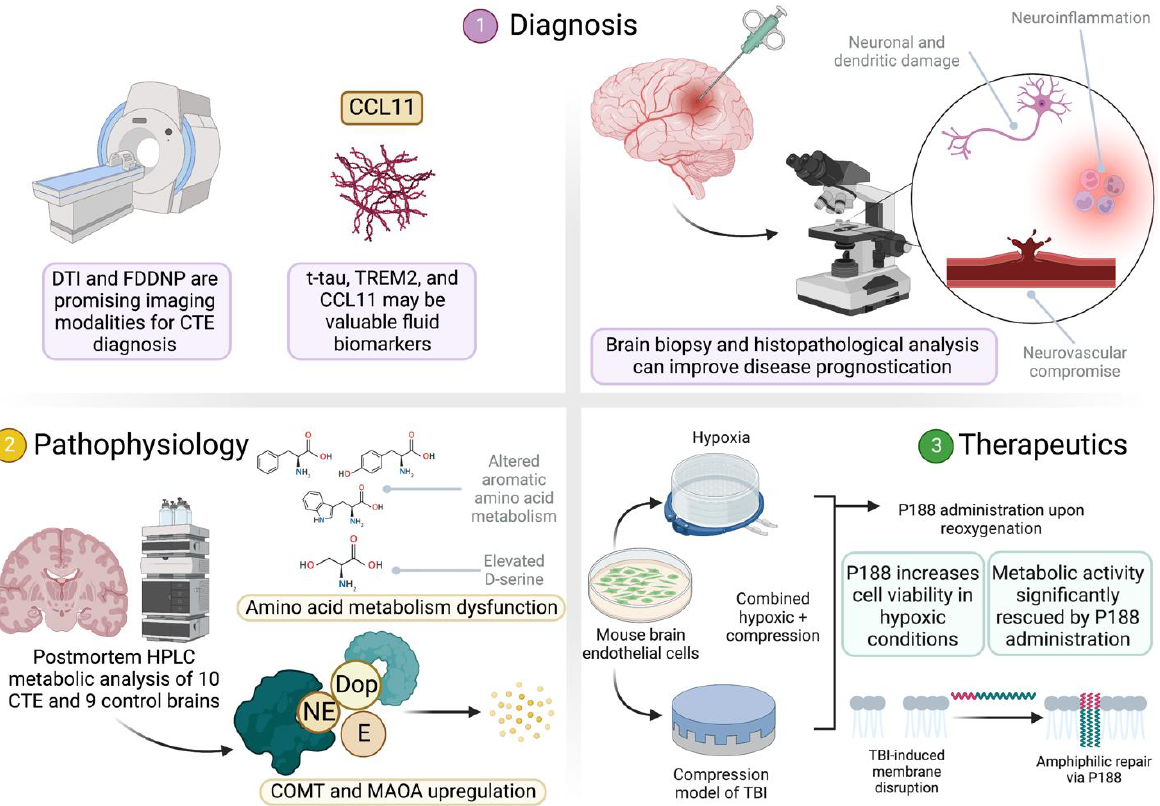
Figure 1. Overview of studies and findings in this special edition. Figure created with BioRen- der.com (accessed on 9 August